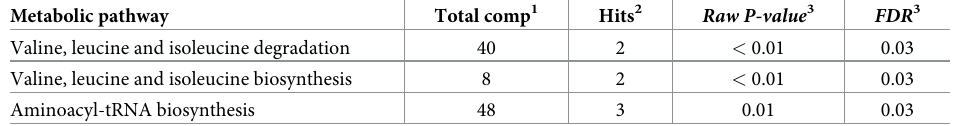
Table 4. Metabolic pathways identified to be differentially altered among contrasting residual feed intake (RFI) Charolais heifers. Metabolic